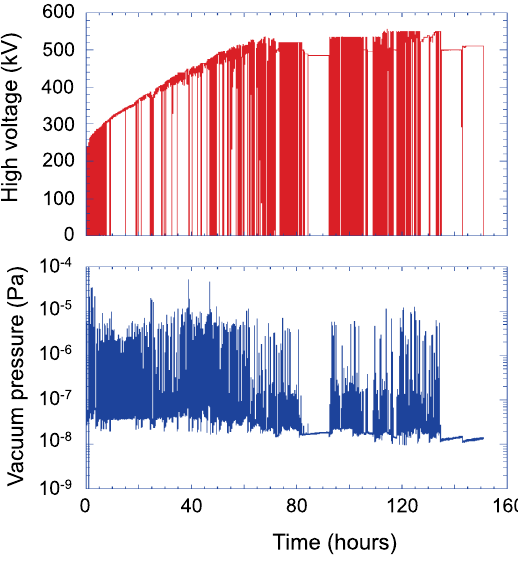
FIG. 12. High voltage (top) and vacuum pressure (bottom) as a function of time during HV conditioning in gun configuration (D), shown in Fig. 11(a). A dummy cap is connected to the bottom of the stem electrode instead of a cathode